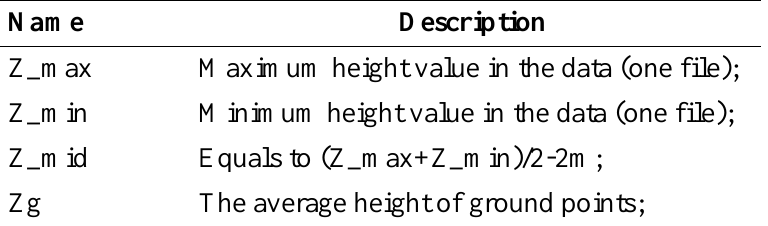
Table 3. A list of name